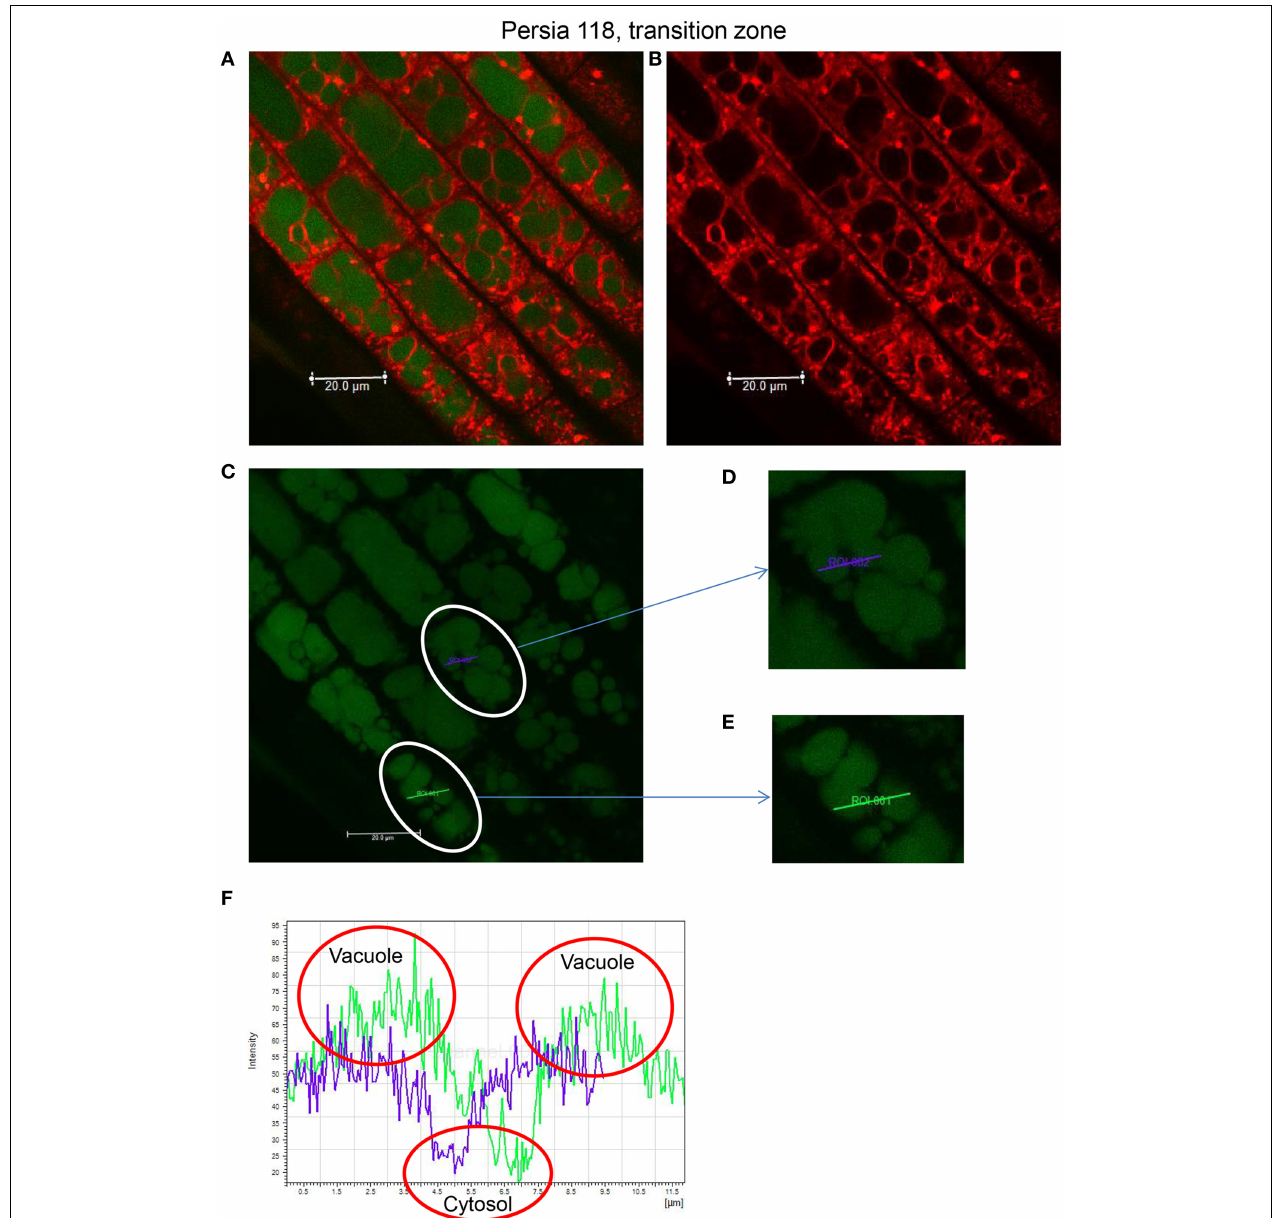
FIGURE 2 | Quantifying intracellular Na + distribution between the cytosol and the vacuole by double staining procedure. Intracellular Na + distribution is illustrated using the transition zone of cultivar Persia 118 as an example. (A) The root transition zone co-stained with Corona Green AM and FM4-64. The same root stained with FM4-64 dye (B)